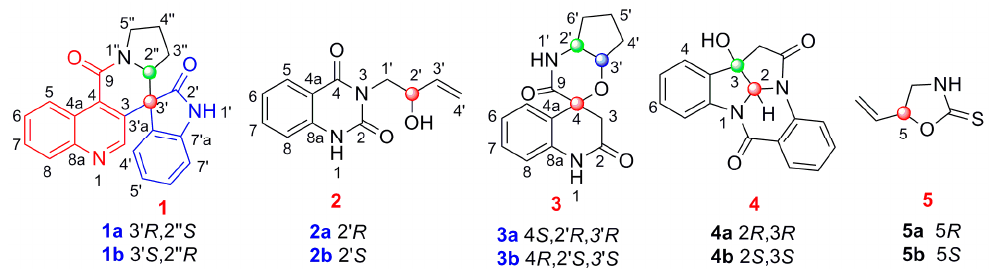
Figure 1. Structures of compounds 1a/1b – 5a/5b.